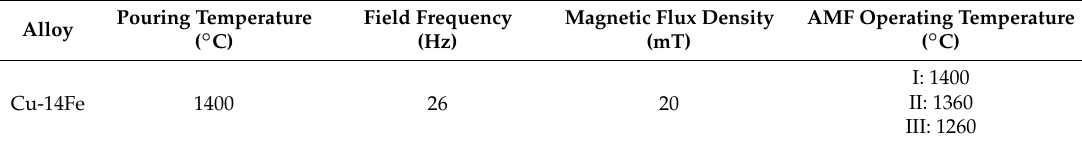
Table 2. Parameters of Cu ‐ Fe alloys solidification technique.